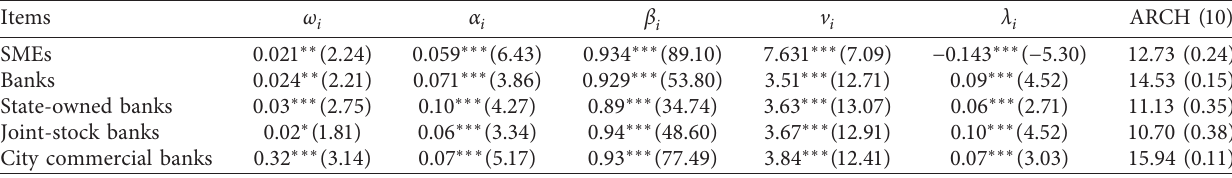
Table 2: Parameter estimation results of the GARCH(1, 1) model and skewed-t